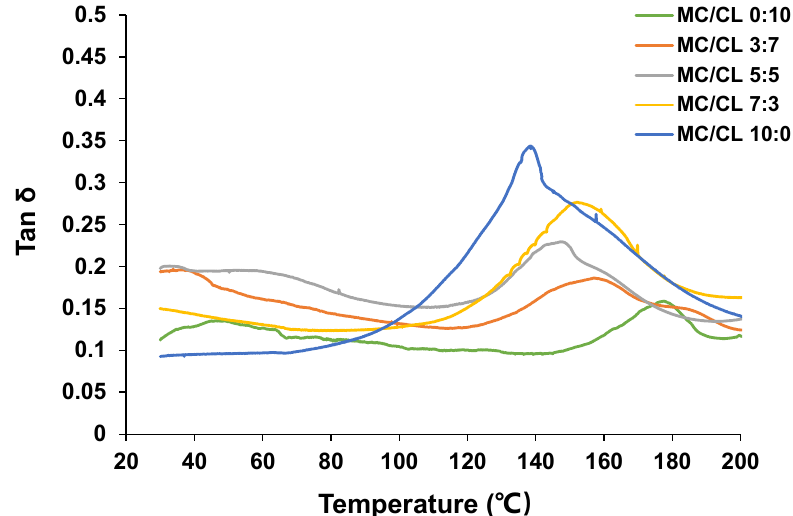
Figure 2. Tan δ curves of MC/CL films.